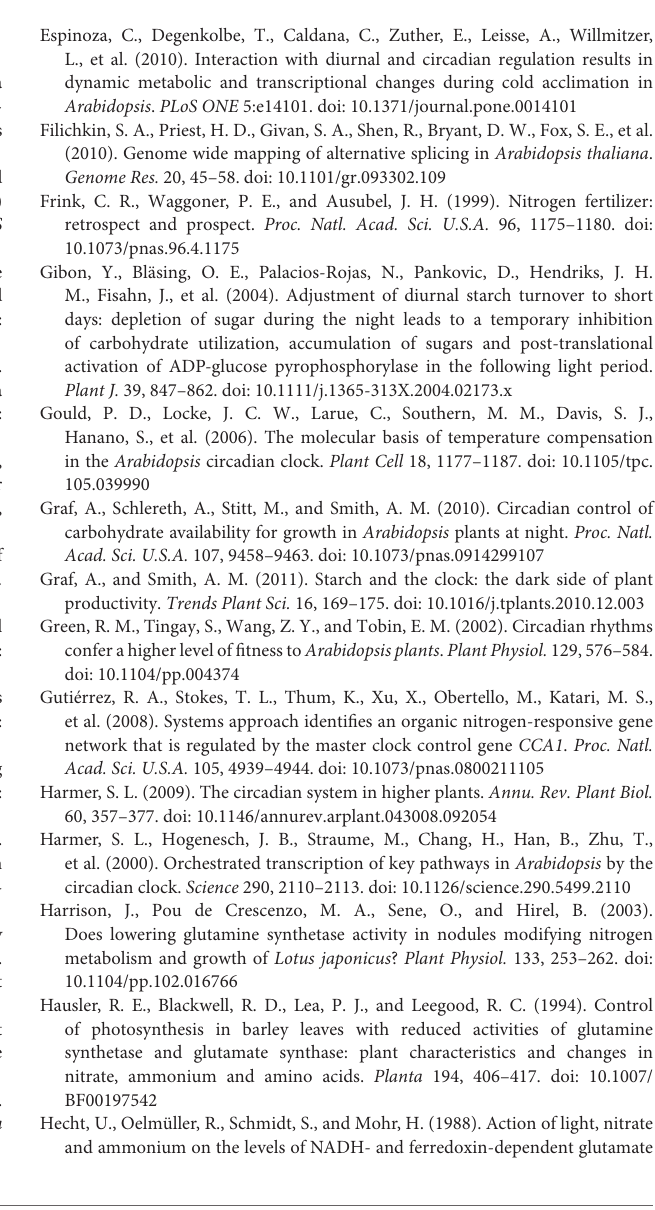
Supplementary Figure S8 | Heatmap of the mature miRNAs at the time of 2:00, 6:00, 10:00, 14:00, 18:00, and 22:00. Supplementary Table S1 | Primer sequences used in qRT-PCR. Supplementary Table S2 | Reads of mRNA sequencing in rice shoots at different time points. Supplementary Table S3 | Mapped events of mRNA sequencing in rice shoots at different time points. Supplementary Table S4 | Reads of small RNA sequencing in rice shoots at different time points. Supplementary Table S5 | Number of mature miRNA in rice shoots at different time points. Supplementary Table S6 | Target genes of osa-miR1440b, osa-miR2876-5p, osa-miR1877, and osa-miR5799 predicted by